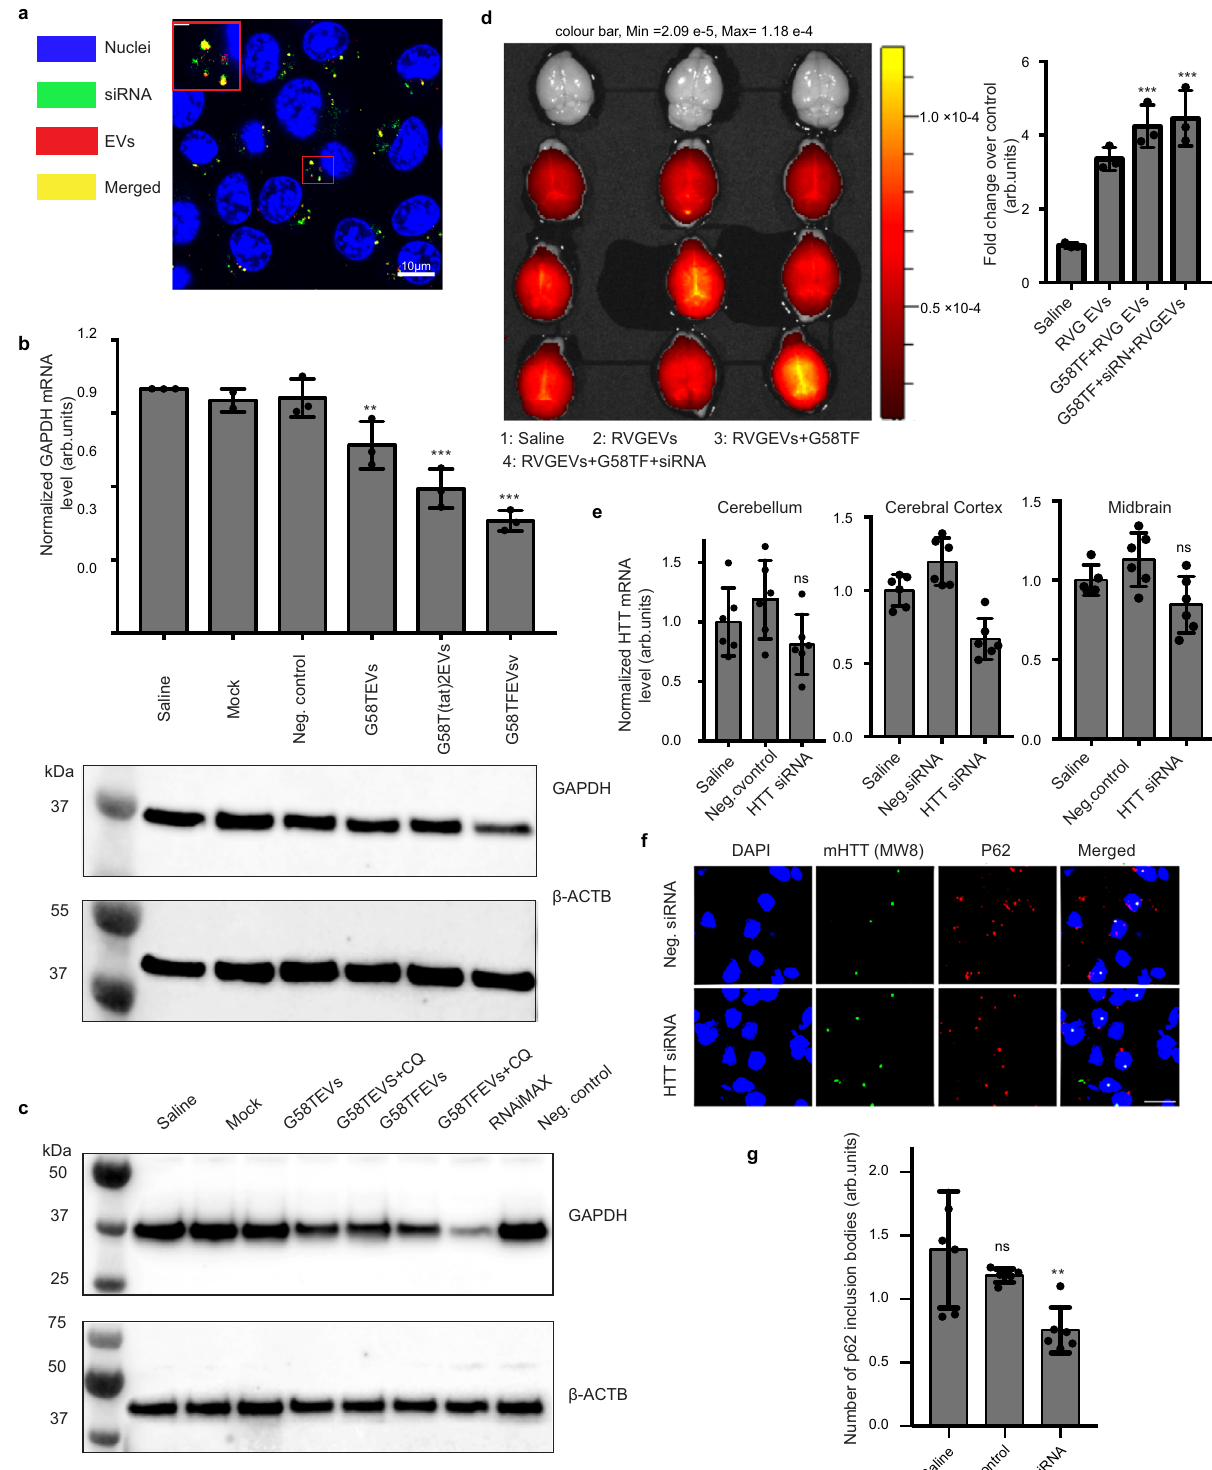
rich peptide of fl ock house nodovirus (FHV) to the G58T protein. (Fig. 4b; Supplementary Fig. 7f). HA2 chimeric proteins could not These peptides have previously been successfully used to enhance be expressed due to toxicity of the peptide in the E. coli producer the release of drugs from late-endosomes 48,49 . Attachment of cells. Further treatment of cells with chloroquine, an endoso- either two TAT peptides or the FHV peptide to the G58T protein molytic molecule 50 , enhanced gene silencing ef fi ciency to around 80%, consistent with the release of entrapped siRNA from late- (designated as G58T(tat)2 and G58TF respectively) resulted in endosomes (Fig. 4c; Supplementary Fig. 7g and 7h). Taken signi fi cantly improved activity with ~35 and 60% silencing of together, these results show highly ef fi cient loading and delivery endogenous genes ( GAPDH and HTT ) in the cells, respectively NATURE COMMUNICATIONS|